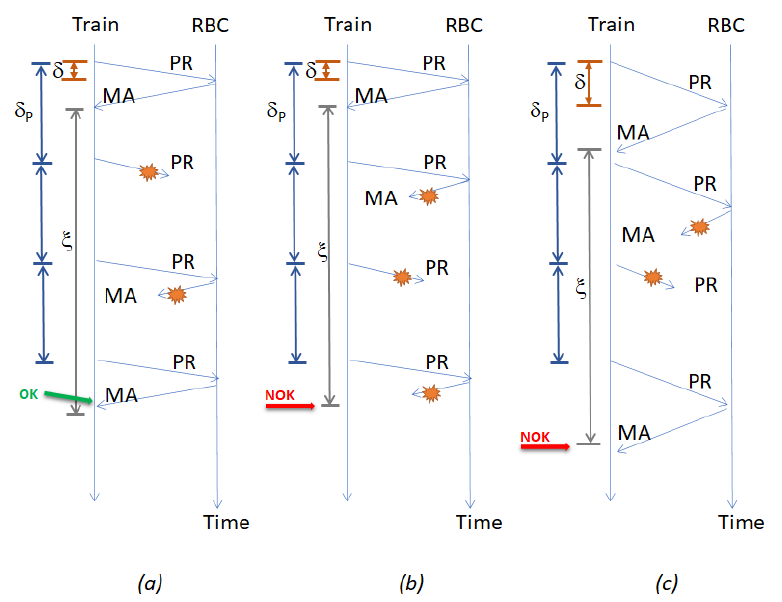
Figure 11. PR/MA Procedure with a PR transmission period δ P , a channel latency δ and a MA receiv- ing threshold ξ : ( a ) successful case; ( b ) unsuccessful case due to high packet loss; ( c ) unsuccessful case due to high packet loss and high channel